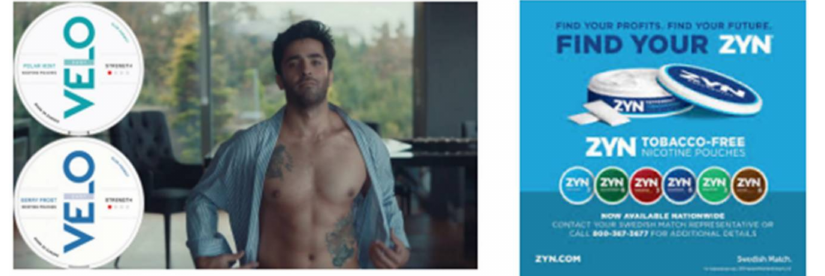
Figure 1. Advertisements for Velo and Zyn shown to